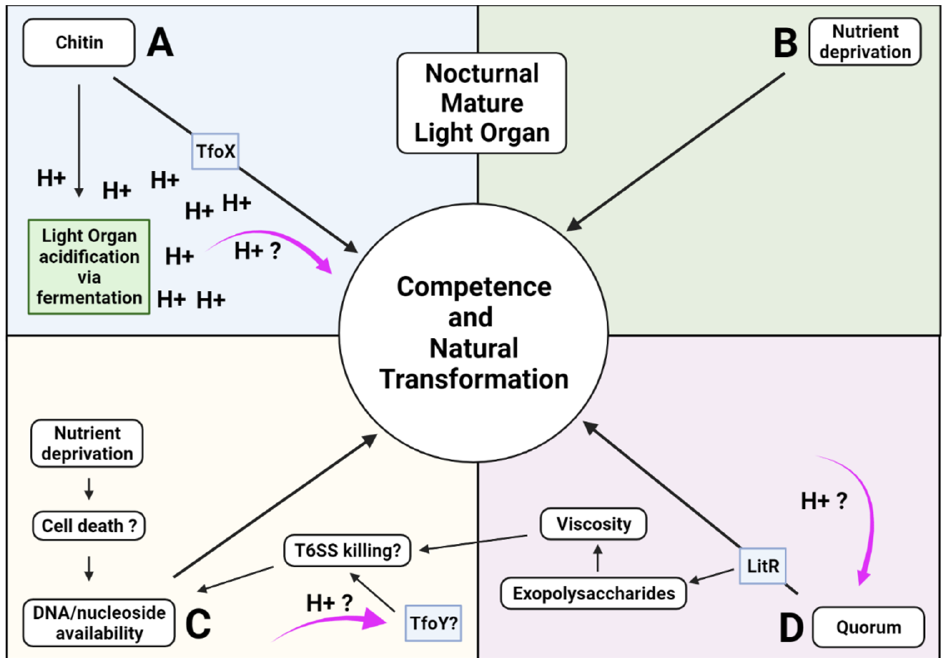
Figure 2. Environmental conditions in the nocturnal light organ conducive to the induction of com- petence and natural transformation in V. fischeri symbionts. The four known cardinal environmental inducers of competence are shown in separate quadrants ( A – D ), with arrows indicating induction pathways (not all intermediate pathway enzymes are represented). The putative effects of low pH on the individual induction signals are represented by fuchsia arrows. ( A ) Host-secreted chitin lowers pH via fermentation. Lowered pH may directly act as a competence inducer as it does in some Gram+ species. [89]. ( B ) Nutrient deprivation towards the end of the night has been inferred in the light organ [86–88]. ( C ) Nutrient deprivation-induced cell death, along with T6SS-mediated killing, provide a source of DNA/nucleosides. ( D ) Low pH is known to modulate quorum-sensing signaling in some gram positive species. [89].